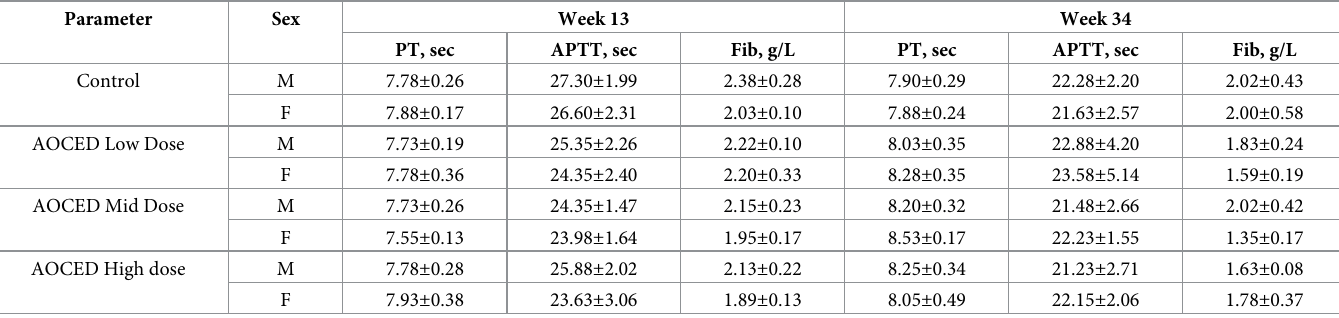
Values are given as mean ± SD (n = 4 per group). APTT—Activated Partial Thromboplastin Time; Fib—Fibrinogen; PT—Prothrombin Time. No statistically significant differences were observed among groups (p < 0.1).